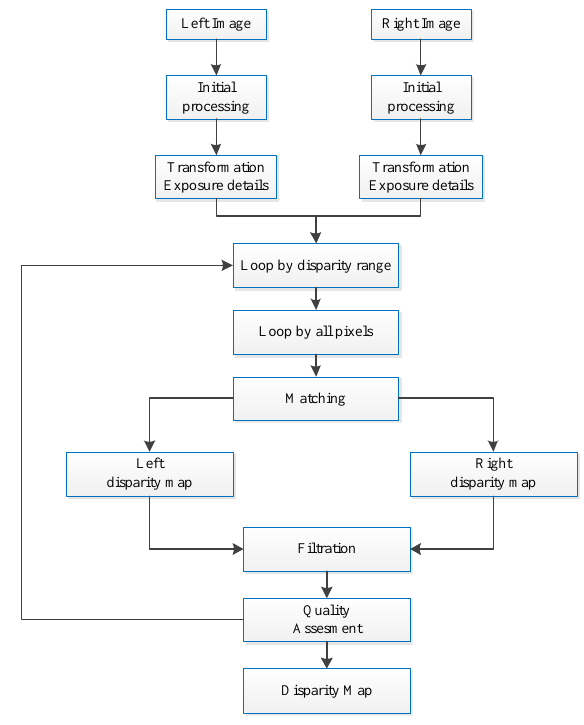
Figure 6. Diagram of the stereovision algorithm matching by areas